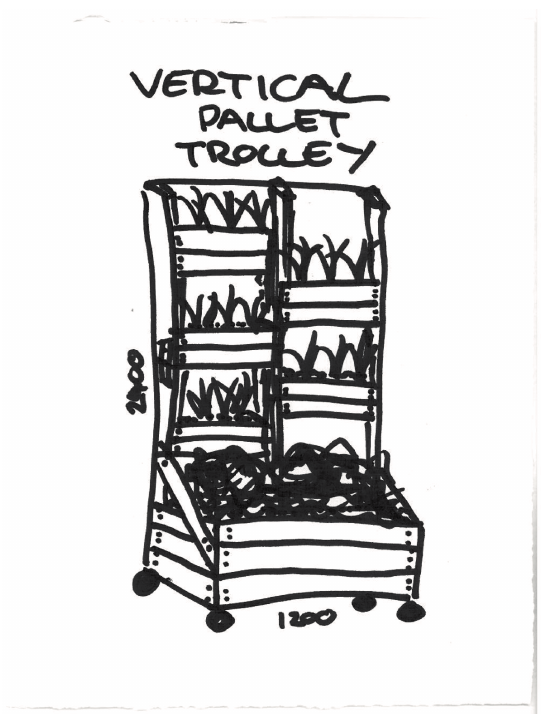
Figure 2. Concept design Vertical Pallet